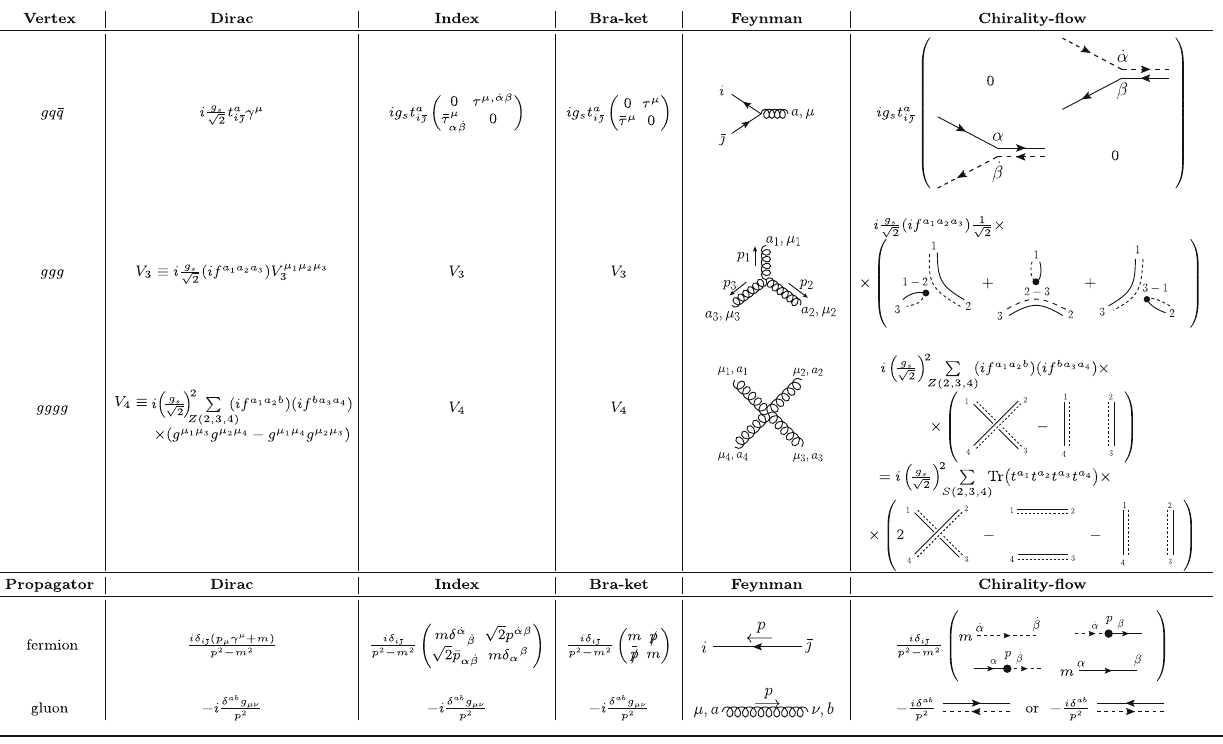
(cid:3) (cid:4) = δ ab t a t b